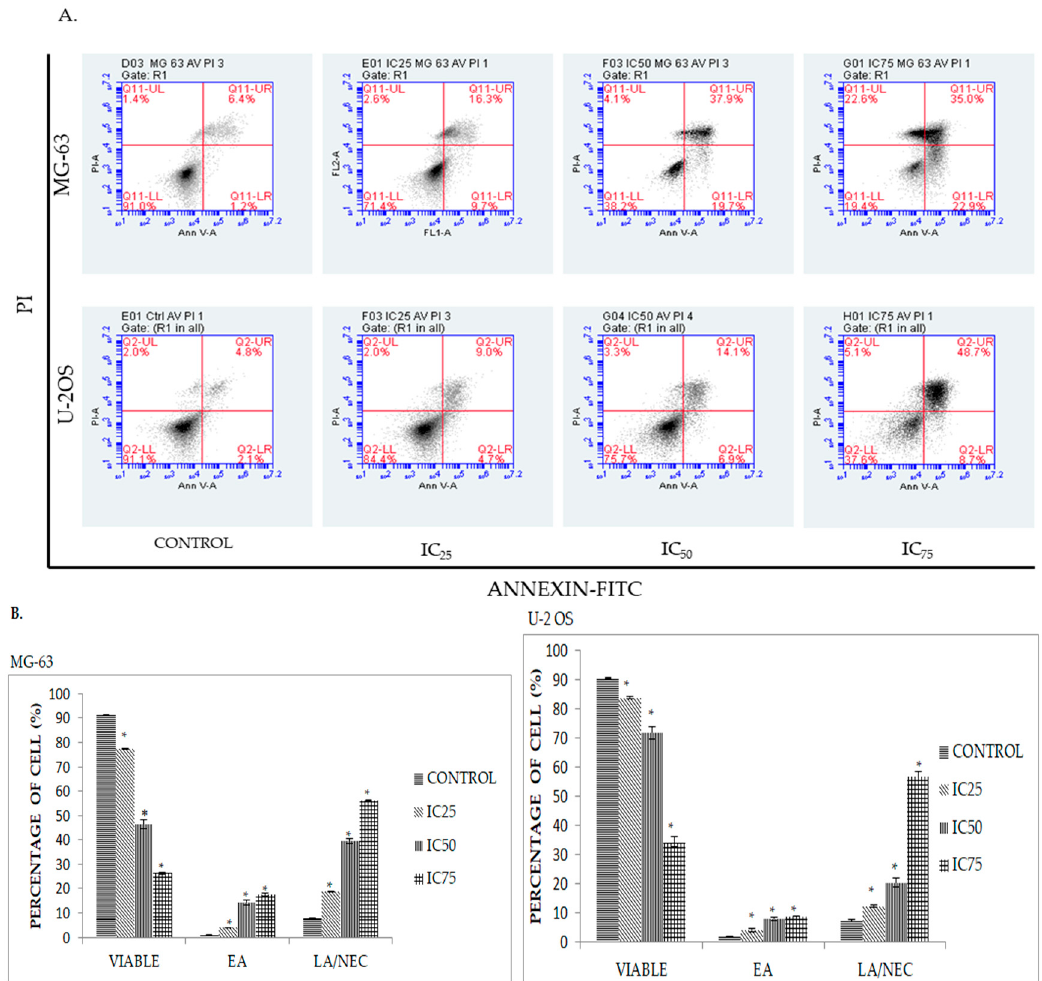
Figure 3. ( A ) Histogram analysis of Annexin V/ FITC in MG-63 and U-2OS after being treated with three different concentration of DK1 (IC 25 , IC 50 , IC 75 ) for 48 h. There are four quadrants in the histogram with different quadrants indicating different types of cell population; LL (viable), LR (early apoptosis), UR (late apoptosis), UL (necrosis); ( B ) Quantification analysis of MG-63 and U-2OS based on percentage of cells that undergo apoptosis. EA (early apoptosis), LA (late apoptosis), NEC (necrosis). All data are expressed as mean ± standard error mean (S.E.M). * p < 0.05 compared with corresponding controls.